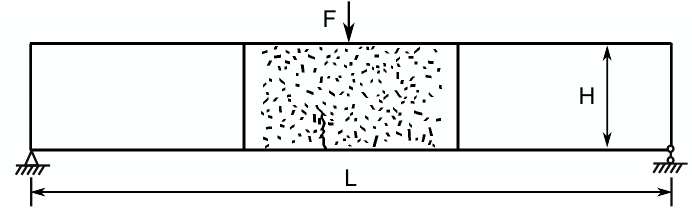
Figure 6. Model of a three-point bending concrete beam.